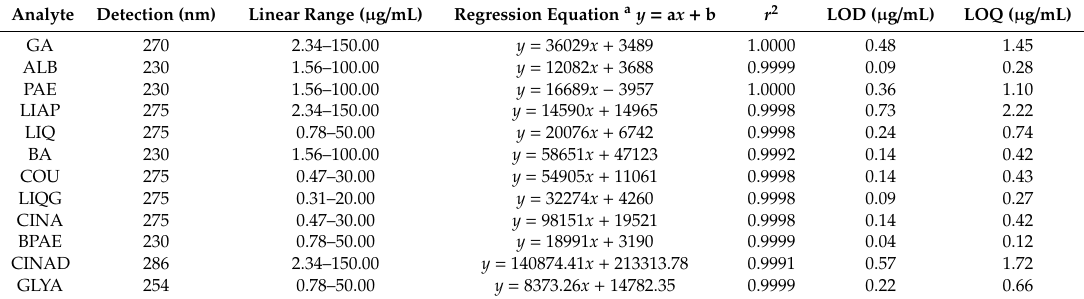
Table 1. Linear range, regression equation, coe ffi cient of determination ( r 2 ), limit of detection (LOD), and limit of quantification (LOQ) for marker analytes (n = 3).